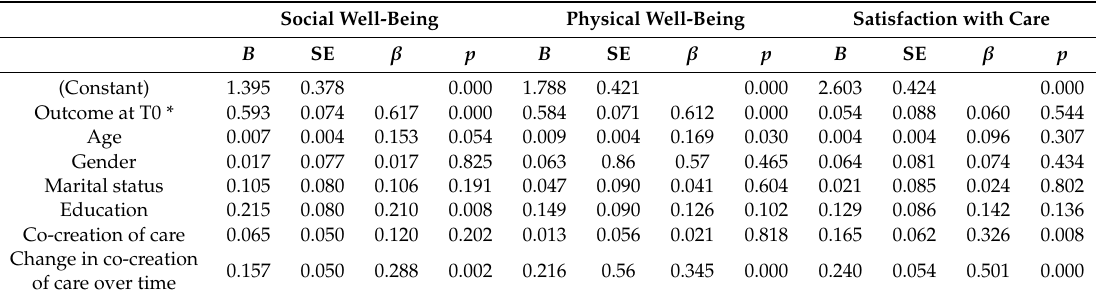
Table 4. Multivariate relationships between co-creation of care, satisfaction with care, social and physical well-being over time. Social Well-Being Physical Well-Being Satisfaction with Care B SE β p B SE β p B SE β p (Constant) 1.395 0.378 0.000